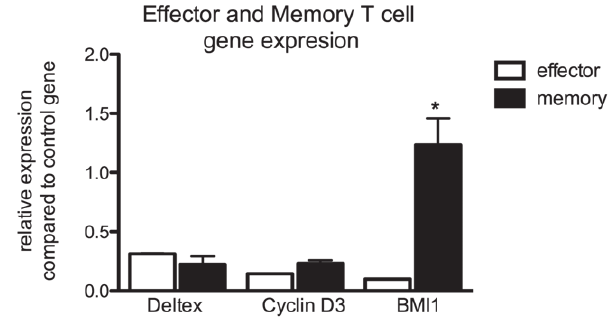
Figure 4. BMI1 expression is higher in memory cells than effector cells. Memory and effector cells were isolated from animals immunized for 6 weeks with S. Mansoni eggs. RNA was isolated, amplified, and quantitative PCR performed to assess the expression of genes associated with Notch signaling or proliferation. Results are expressed relative to a control gene (Rplp2) that has been shown to have minimal variation in leukocytes. *p # 0.01.